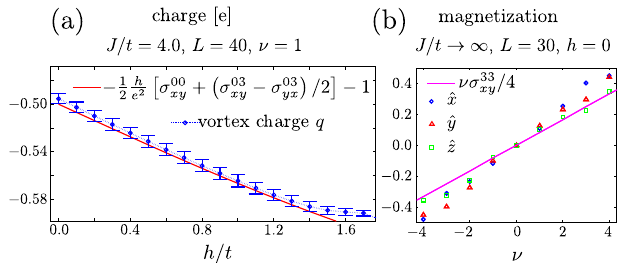
FIG. 8. (a) Zeeman-field dependence of the vortex charge. Blue circles were obtained by exact diagonalization. The red solid line is the expected result from a Laughlin adiabatic argu- ment. (b) Net magnetization accumulated near the vortex for different windings and with rotations around the z axes. Both results were obtained for 3 = 4 electronic filling.